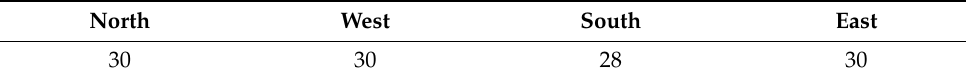
Figure 8. Scatter plots of the sDA 300/50% and ASE 1000,250 due to number of slat variation each direction. Table 3. Optimum number of slats in the fixed shading design option.